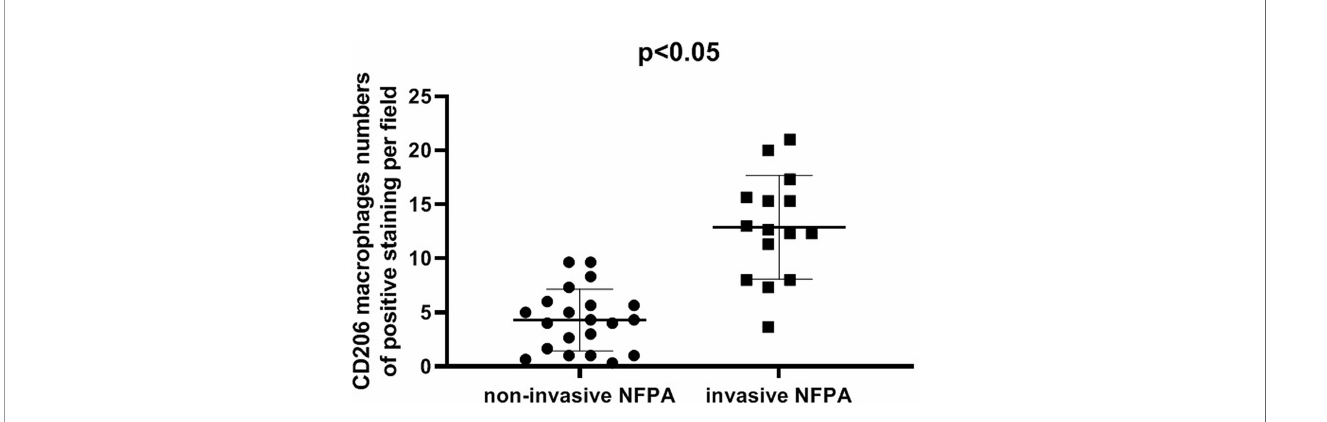
FIGURE 6 | Comparison of CD206 macrophage expression between invasive nonfunctioning pituitary adenoma (NFPA) and non-invasive